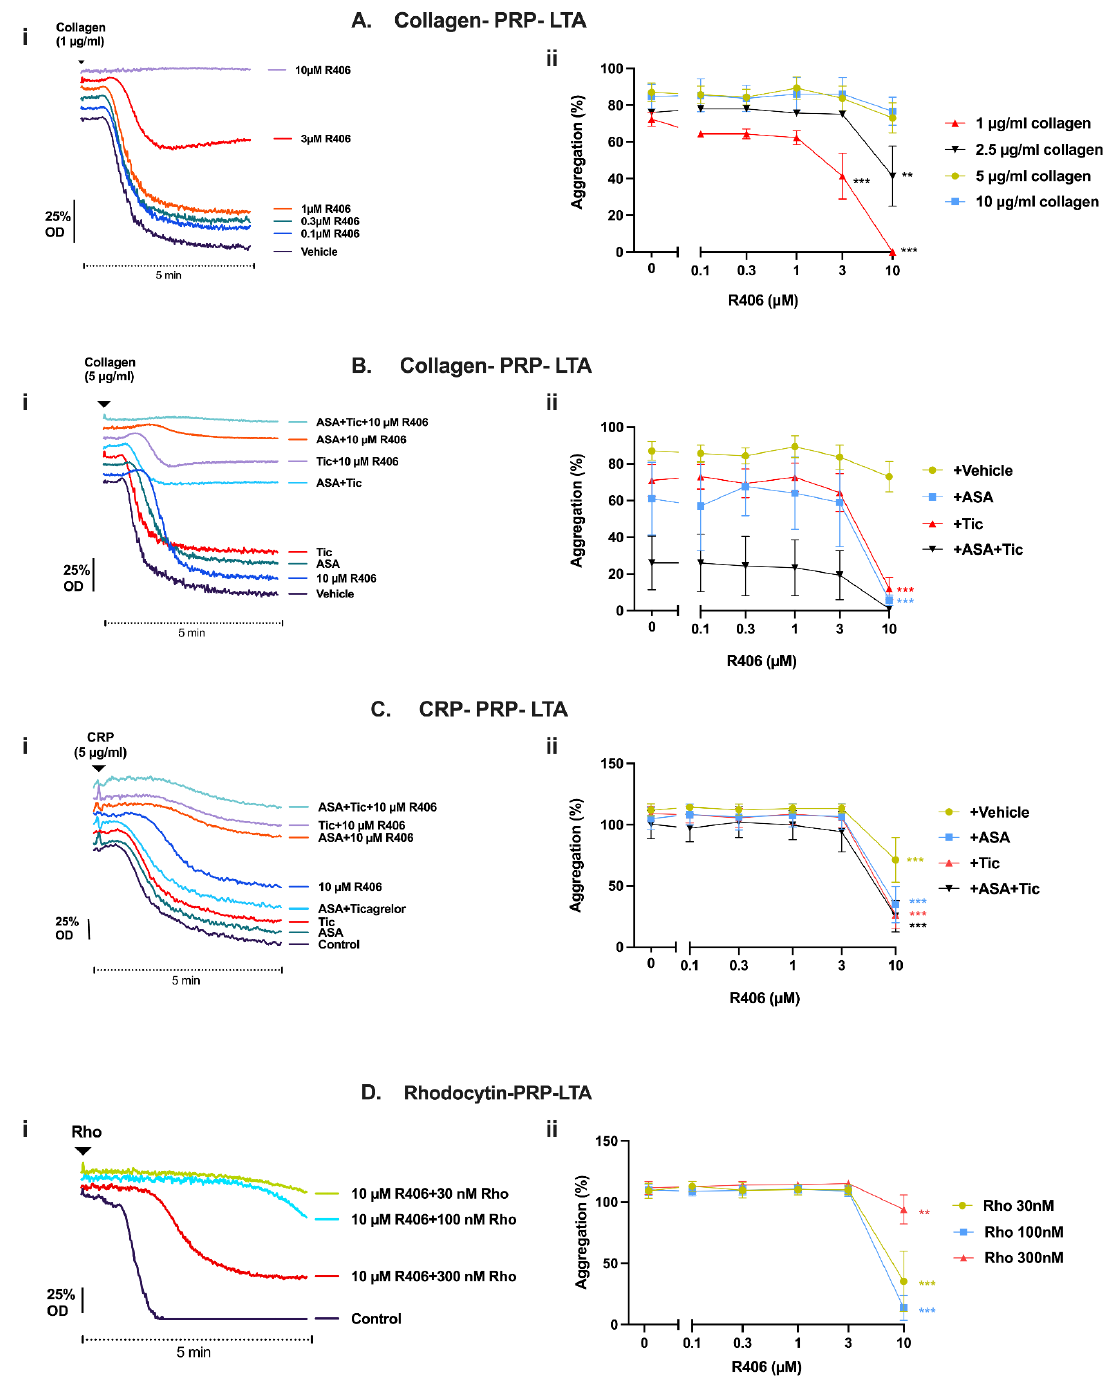
Figure 5. Effect of R406 in combination with aspirin and/or ticagrelor on collagen- and CRP-mediated platelet aggregation and effect of R406 on rhodocytin-mediated platelet aggregation. ( A – C ) GPVI- and ( D ) CLEC-2-mediated platelet aggregation in healthy donor PRP assessed with LTA. Samples were incubated with either vehicle (0.1% DMSO), R406, 30 µ M of aspirin and/or 1 µ M of ticagrelor for 10 min, then stimulated with ( A ) 1–10 µ g/mL of collagen, ( B ) 5 µ g/mL of collagen, ( C ) 3 µ g/mL of CRP, or ( D ) 30–300 nM of rhodocytin to induce aggregation. (i) Representative platelet aggregation traces. Full sets of traces are provided in Supplementary Materials, Figure S6 and Figure S7. Results are shown as mean ± SEM of three independent experiments. Results analysed with two-ANOVA with Dunnett’s correction for multiple comparisons vs. vehicle control. ** p < 0.01, *** p < 0.001. ASA, aspirin. Tic, ticagrelor, Conc,